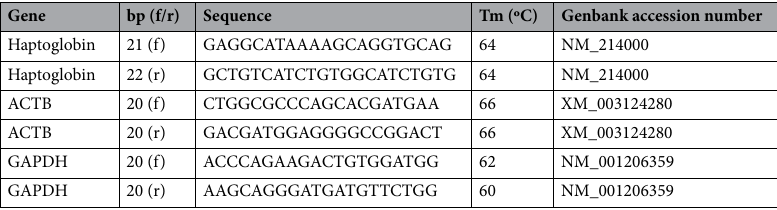
Table 2. Primer information for real time RT-PCR amplification of haptoglobin, β-actin (ACTB) and Glyceraldehyde-3-phosphate dehydrogenase (GAPDH)